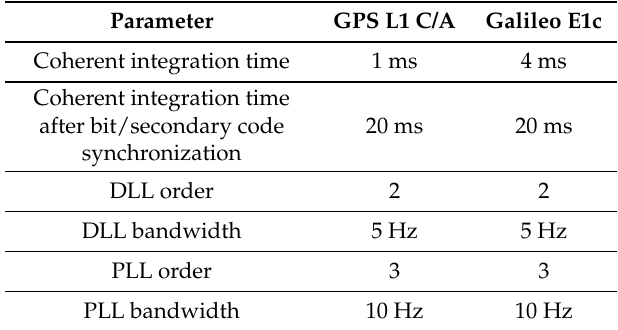
Table 3. Summary of the parameters adopted for the processing of the GPS L1 C/A and Galileo E1c